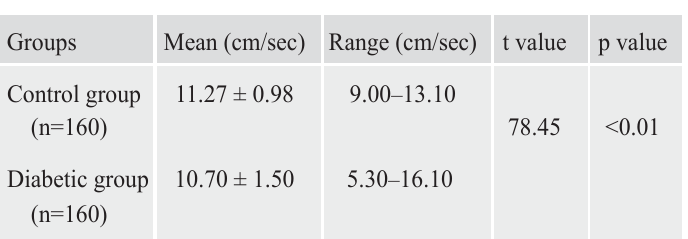
Table I: Comparison between mean peak systolic velocity of retinal artery of 160 control eyes and 160 diabetic